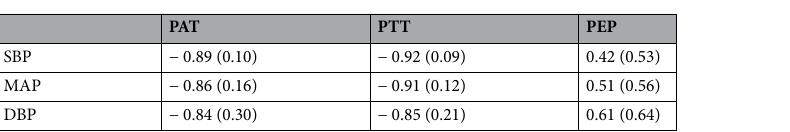
Table 2. Correlation coefficients for PAT, PTT and PEP to SBP, MAP and DBP for all the volunteers in the study. Values are given as median (IQR).